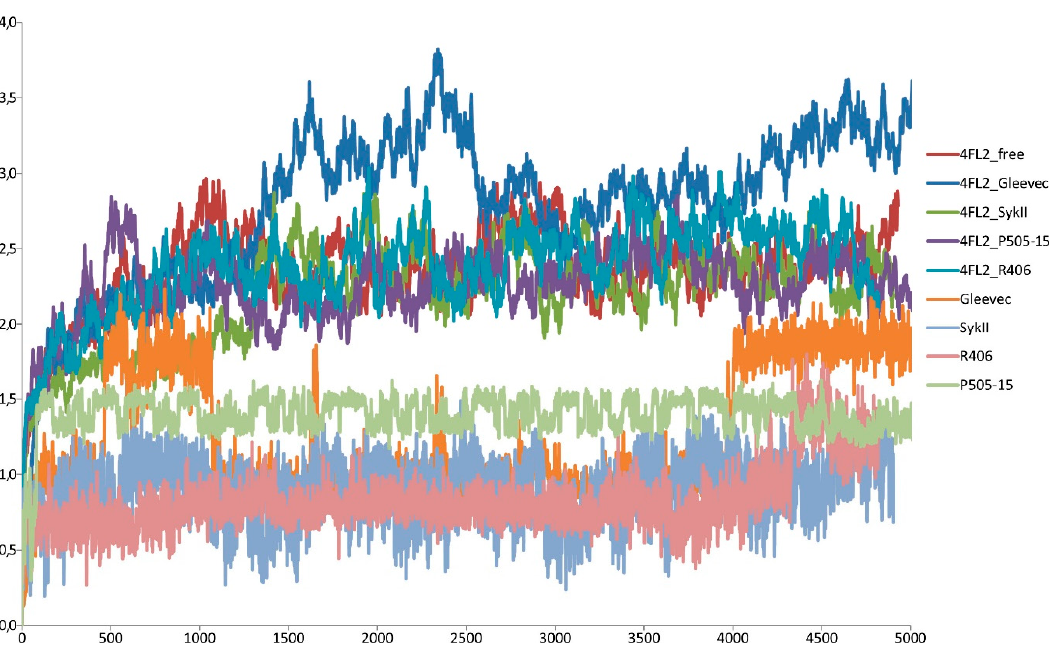
Figure 6. Root mean square deviation (RMSD) values (values on the y -axis reported in Å) for all atoms calculated over 10 ns, with the values on the x -axis reported as steps (1 step = 2 ps) of 4FL2, the compounds alone, and the four complexes—4FL2-Gleevec, 4FL2-SykII, 4FL2-R406, 4FL2- P505-15.